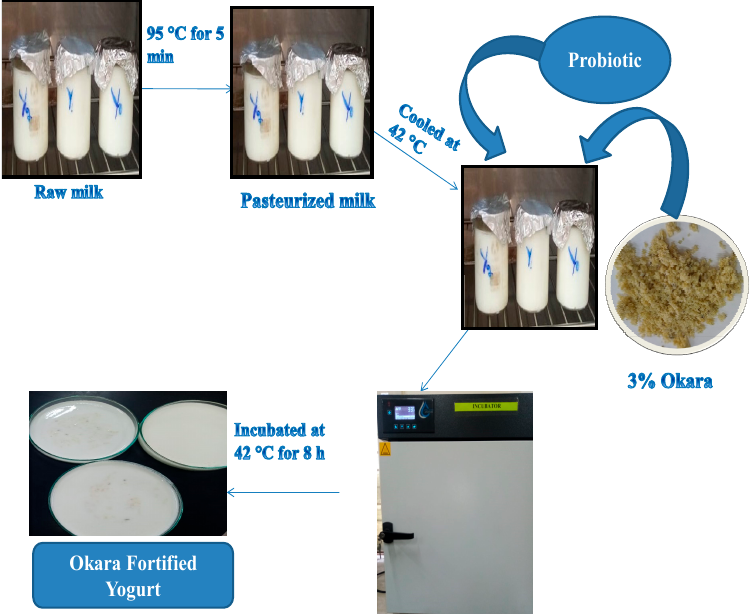
Figure 1. Schematic diagram of okara fortified yogurt (Synbiotic yogurt).